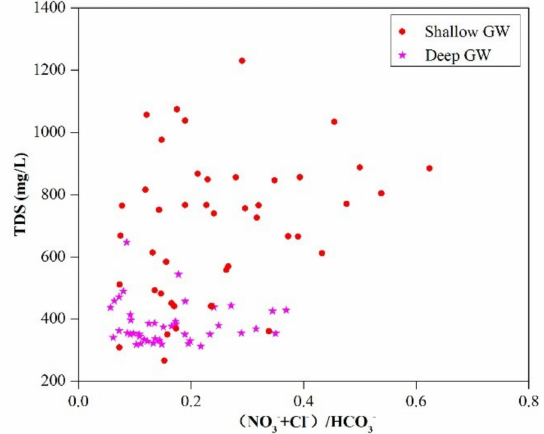
Figure 9. Bivariate diagram of TDS versus (NO 3 − + Cl − )/HCO 3 −